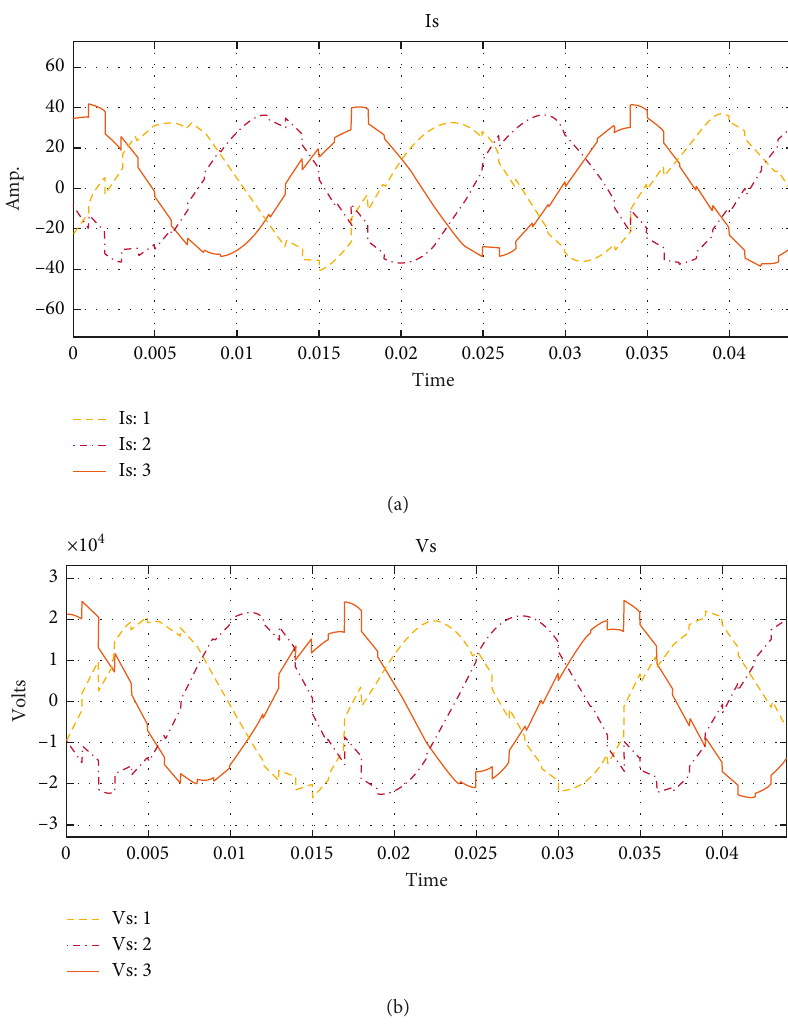
Figure 8: PMU current and voltage signals with noise.